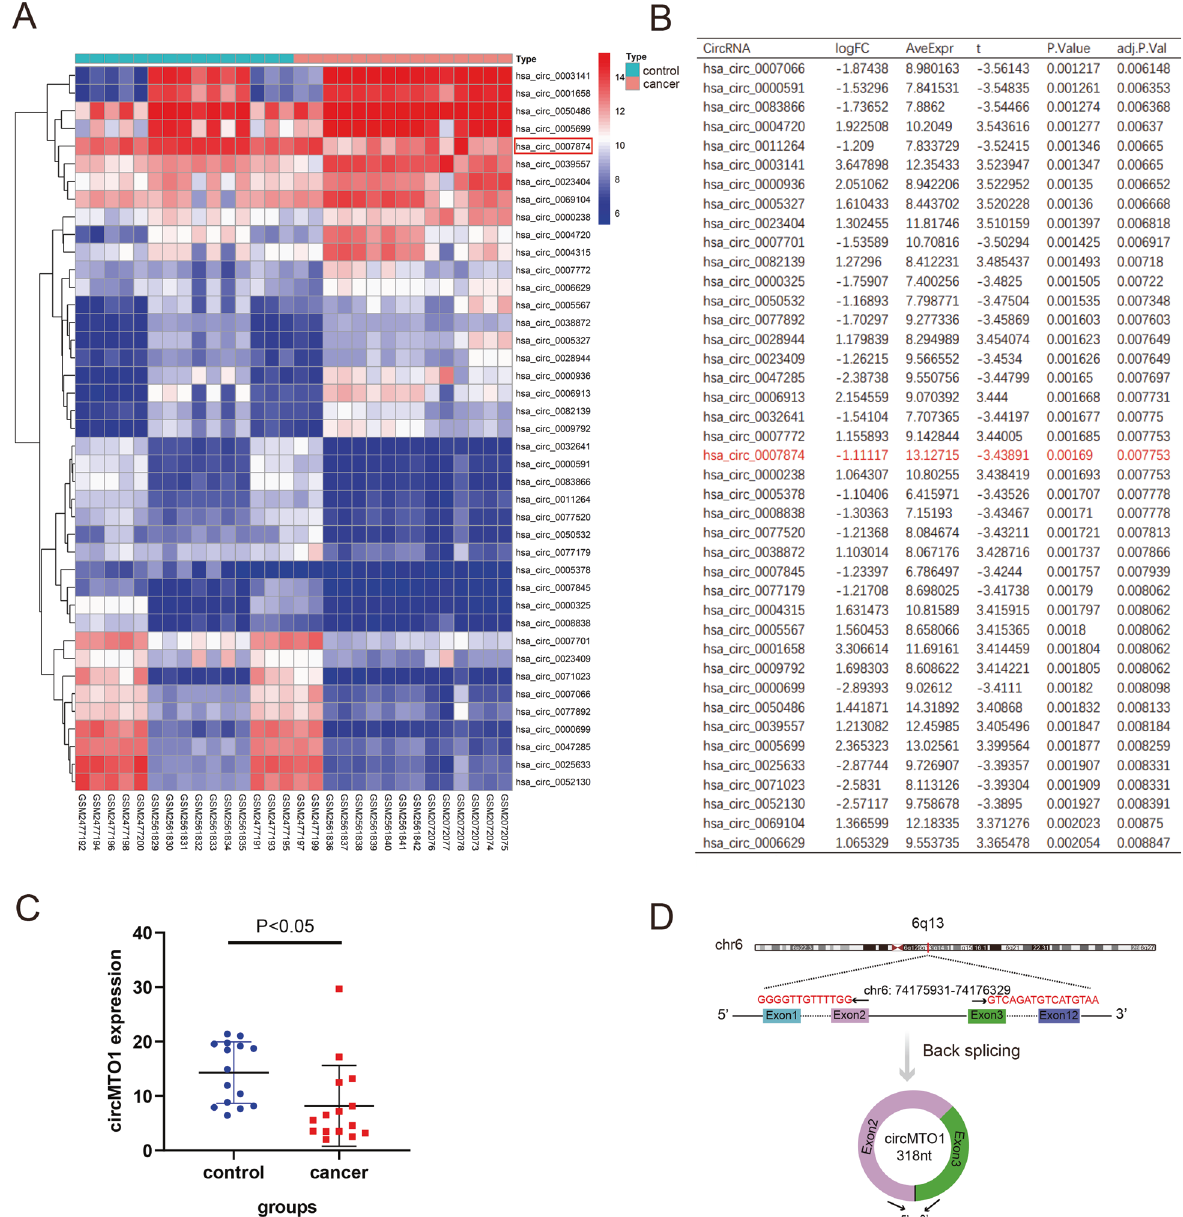
Fig. 1 Screening for differential expression of circRNA. A Part of the downregulated differently expressed circRNAs and circMTO1 (hsa_circ_0007874) was highlighted in the red box. B Part of the differently expressed circRNAs shown using the logFC, and circMTO1 (hsa_circ_0007874) was highlighted in the words in red. C The level of circMTO1 was lower in the cancer group compared with the control group. D The pattern map of circMTO1 chromosome location and cyclization. LogFC: The expression ratio of has_circ_0007874(circMTO1) in cancer and control